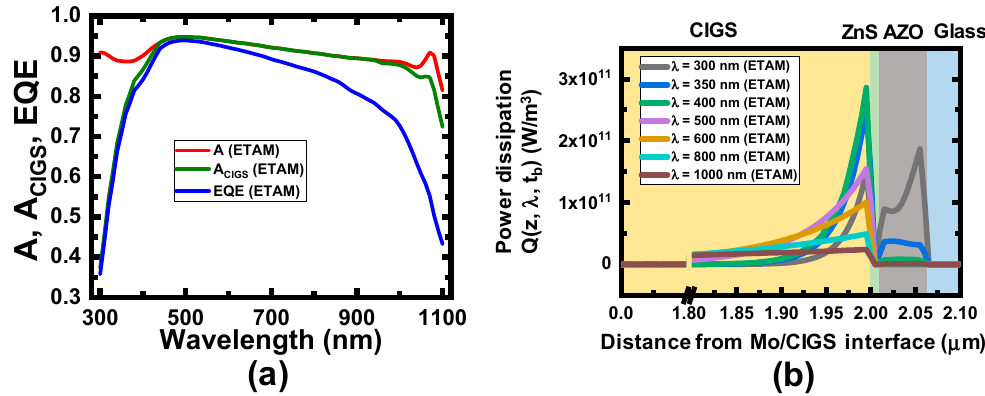
Figure 9. ( a ) ETAM-applied calculation results of absorptivity in the entire multilayer A , absorptivity in the CIGS absorber layer A CIGS and EQE. ( b ) ETAM-applied spatial profiles of the optical power dissipations in the longitudinal z-direction at several wavelengths.